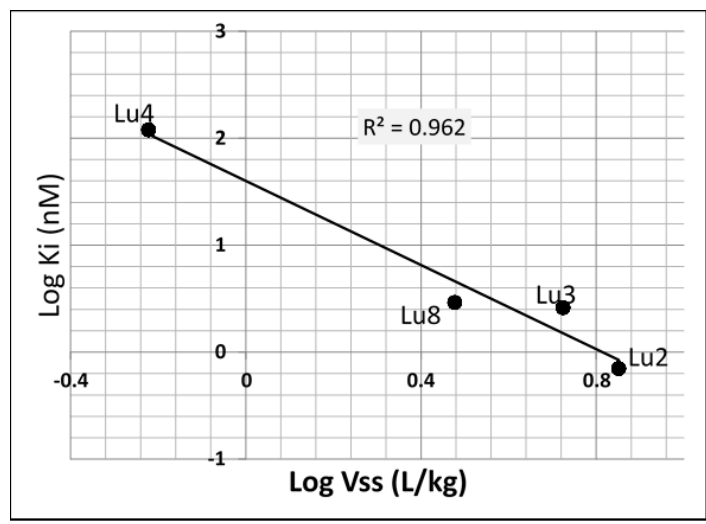
Figure 2. Correlation between affinity for HSP90 and volume of distribution in rats.